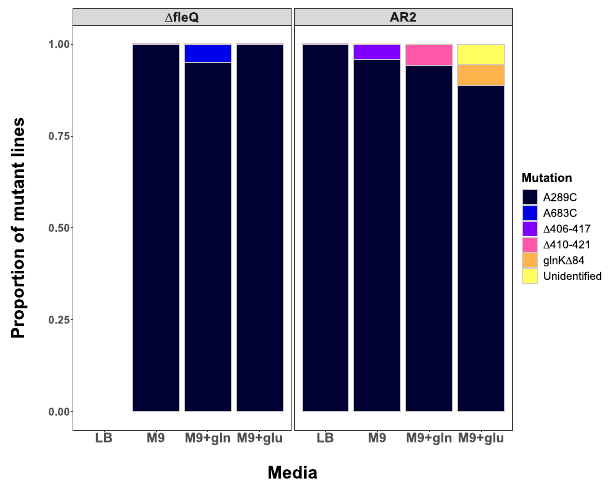
Fig. 2 Repeatable evolution of mutation ntrB A289C is robust across genetic background and nutrient environment (total N = 116). The proportion of each observed mutation is shown on the y axis, and each unique mutational target is highlighted by a colour. Lines were evolved using 4 mM, 8 mM and 16 mM of amino acid supplement glutamate (glu) or glutamine (gln; see Methods). No signi fi cant relationship between supplement concentration and evolutionary target was observed (Kruskal – Wallis chi-squared tests, two-sided: AR2 M9 + glu, df = 2, P > 0.2; AR2 M9 + gln, df = 1, P > 0.23; Δ fl eQ M9 + gln, df = 1, P > 0.3), as such they are grouped visually and for subsequent statistical analysis. ntrB mutation A289C was robust across both strain backgrounds (SBW25 Δ fl eQ - shown as Δ fl eQ , and AR2) and the four tested nutritional environments, remaining the primary target of mutation in all cases (>88%). As such no signi fi cant gene-by-environment interaction was observed ( χ 2 = 0.875, df = 3, P = 0.83). Δ fl eQ lines evolved on LB were able to migrate rapidly through sliding motility alone, masking any potential emergent fl agellate blebs (see 37 ). Sample sizes ( N ) for other categorical variables: Δ fl eQ – M9: 25, M9 + gln: 20, M9 + glu: 7; AR2 - LB: 5, M9: 24, M9 + gln: 17, M9 + glu: 18. Source data are provided as a Source Data fi